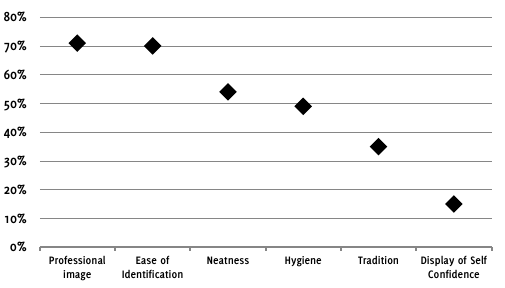
Figure 4. Patients’ Perception of Positive Attributes Represented by the White Coat